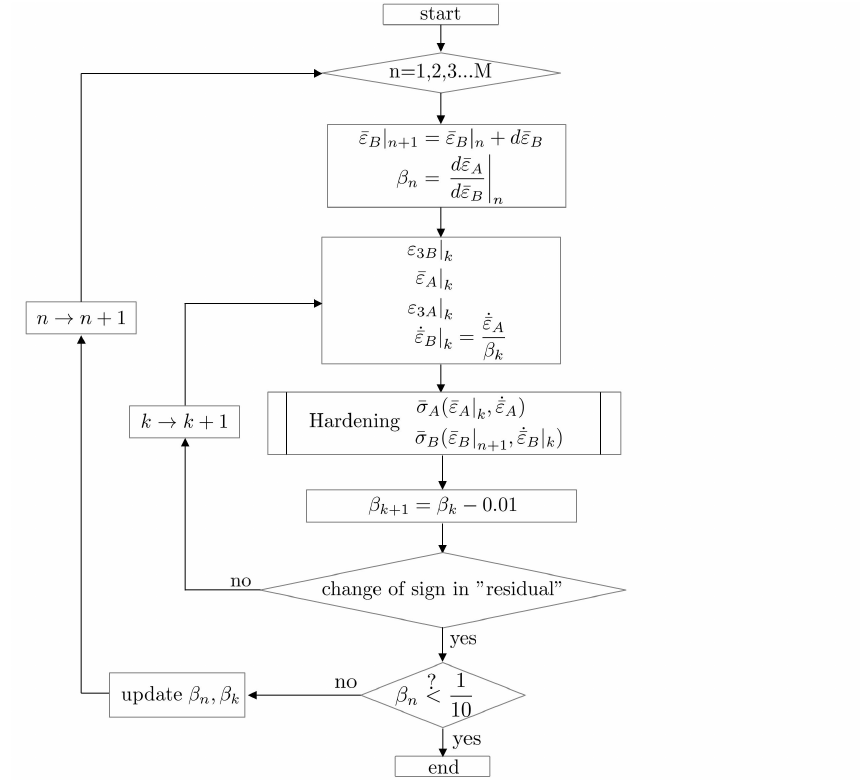
Figure 2. Implemented algorithm in FORTRAN.